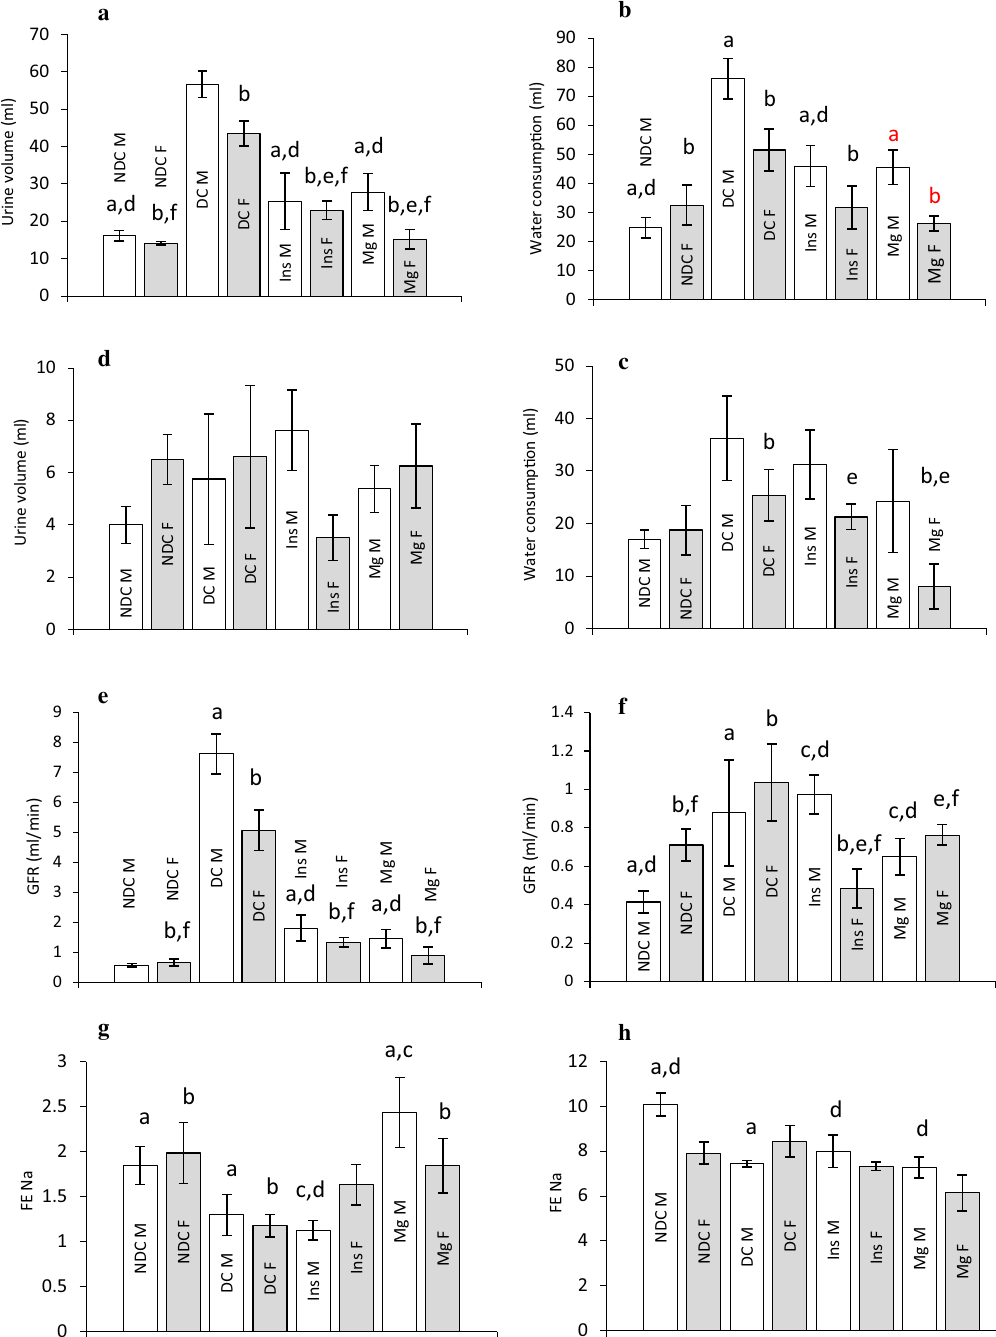
Figure 4. Comparison of water consumption and urine volume in male and female parents and their male and female offspring ( a , b , c and d respectively), glomerular filtration rate (GFR) in male and female parents and their male and female offspring ( e and f respectively), sodium fraction excretion rate (FE Na) in male and female parents and their male and female offspring ( g and h respectively) and glucose fraction excretion rate (FE G) in male and female parents and their male and female offspring ( i and j respectively) in non-diabetic control group (NDC) was fed with normal diet , diabetic group received high-fat diet and 35 mg/Kg STZ (D), diabetic animals treated with insulin (2.5 U/Kg two time per day) (Ins) and diabetic animals treated with 10 g/l magnesium sulfate via drinking water (Mg). 10 rats in each group and data are expressed as mean ± SEM. ( a ) Significant difference between D male group and other male groups ( P < 0.0001). ( b ) Significant difference between D female group and other female group ( P < 0.001). ( c ) Significant difference between male Mg group and male insulin group ( P < 0.001). ( d ) Significant difference between male NDC and male Mg and male insulin groups ( P < 0.001). ( e ) Significant difference between female Mg group and female insulin group ( P < 0.001). ( f ) Significant difference between female NDC and female Mg and female insulin groups ( P <